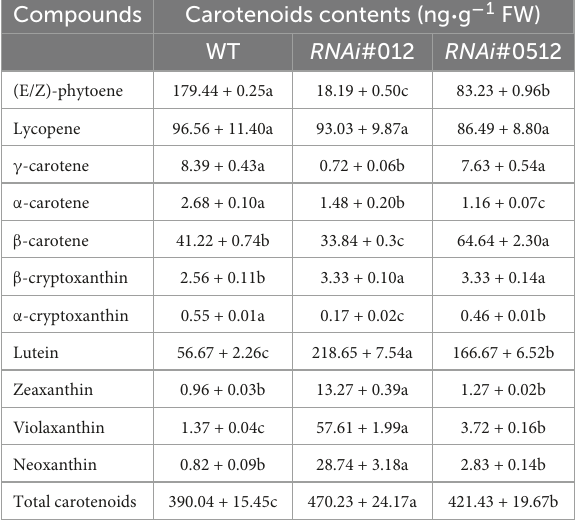
TABLE 1 Carotenoids content of SlBEL11 RNAi and WT tomato